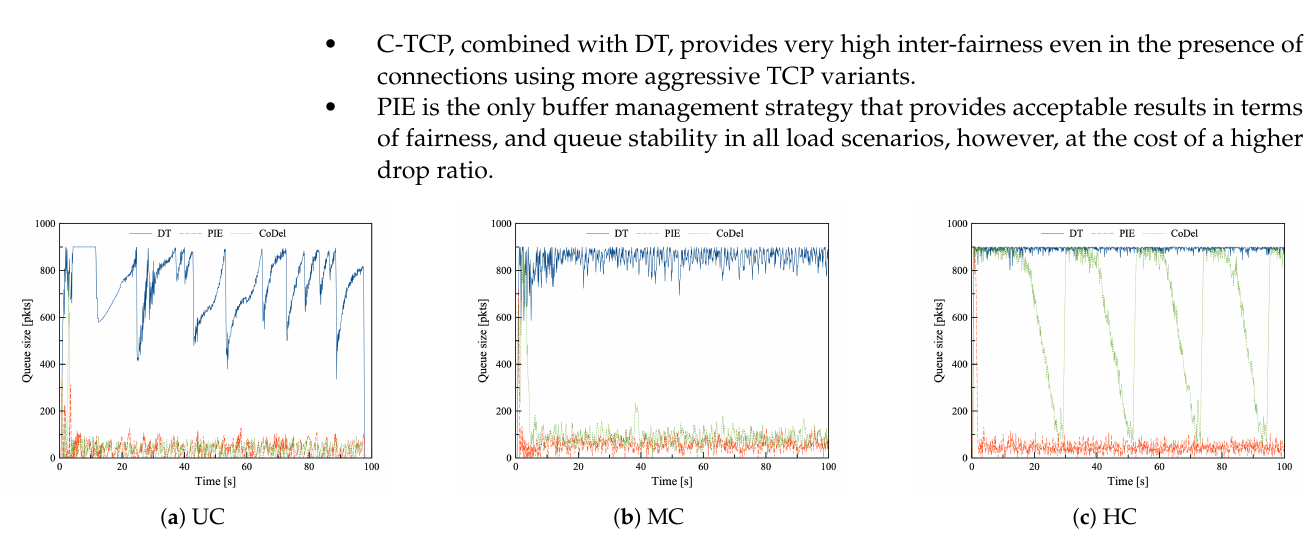
Figure 9. The queue length of DT, PIE and CoDel in combination with mix TCP flows in the Access Link scenario ( a ) in uncongested network, ( b ) during mild congestion, ( c ) during heavy